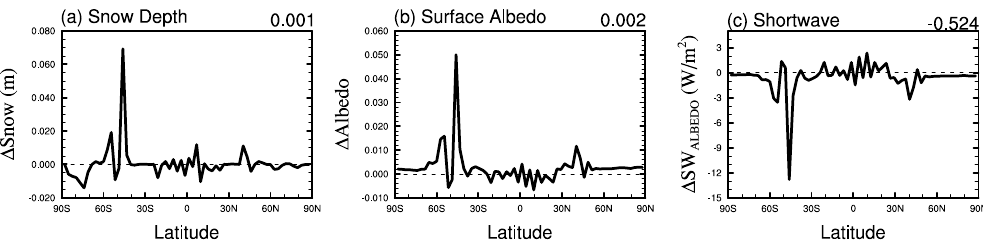
Fig. 6. Changes of snow depth (a) , surface albedo (b) , and absorbed shortwave fluxes (c) due to changes of surface albedo for the case of 50% ozone, relative to the control experiment. All of the values are for annual- and zonal-mean under clear-sky conditions. The CO 2 level is 100ppmv. Global-mean value is shown at the right top of each panel.